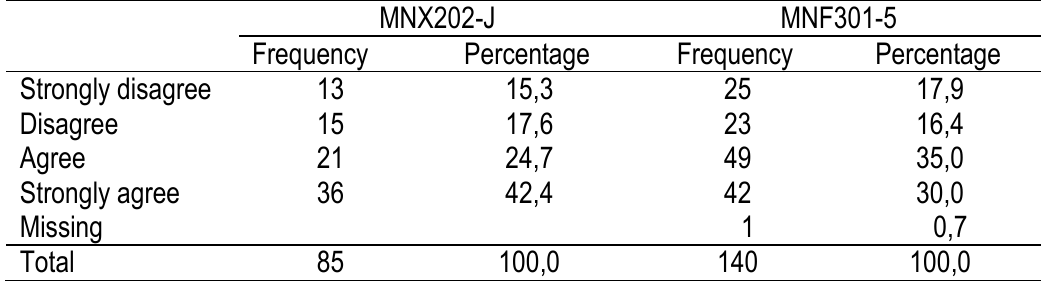
Table A10: The assignments of all the modules should contribute towards the